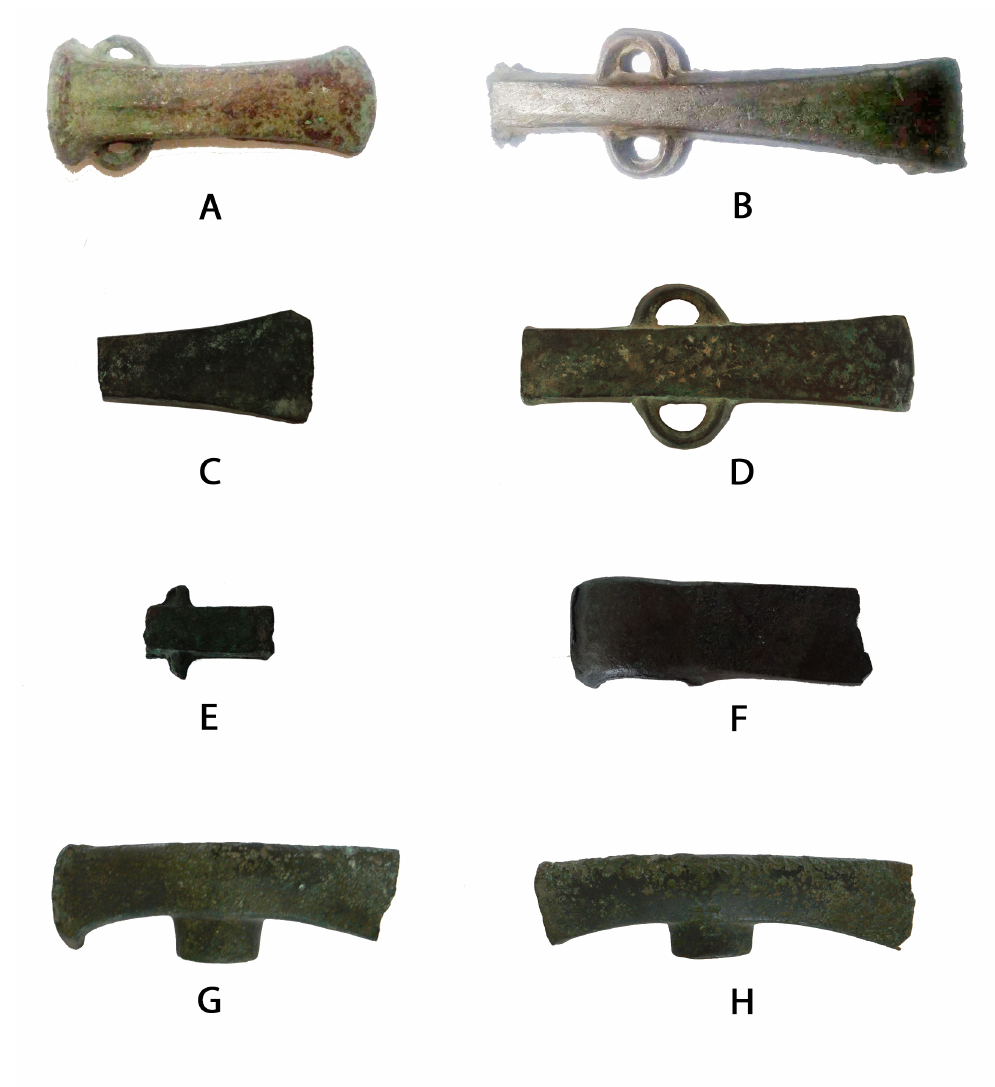
Figure 2. Images of the analyzed axes. Monte Sa Idda (Decimoputzu, CA): ( A ) cannon axe (#36265); Monte Arrubiu (Sarroch, CA): ( B ) flat axe with lateral loops (#39957); Nuraghe Flumenelongu (Alghero, SS): ( C ) fragment of a flat axe with lateral loops (#10273), ( D ) flat axe with lateral loops (#10271), ( E ) fragment of a flat axe with lateral spikes (#10275), and ( F ) shaft-hole axe (#10272); and Funtana Janna (Bonnanaro, SS): ( G ) double axe (#10712) and ( H ) double axe (#10713). Some characteristic shapes of working tools are flat axes with lateral loops, axes with lateral spikes, and cannon axes with loops, which were produced on the Iberian peninsula. Double axes belong to a family of artifacts frequently compared to Cypriot production; the similarities are in the line with only more general features and not specific aspects. Shaft-hole axes, such as sample #10272, are extremely rare in Sardinia but rather common on the Italian peninsula, which confirms a trade relationship between Sardinia and continental